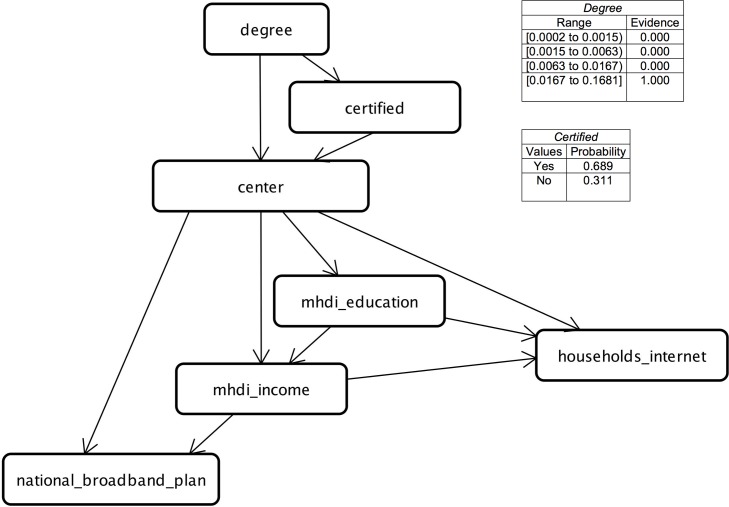
Structure of the Bayesian Network.